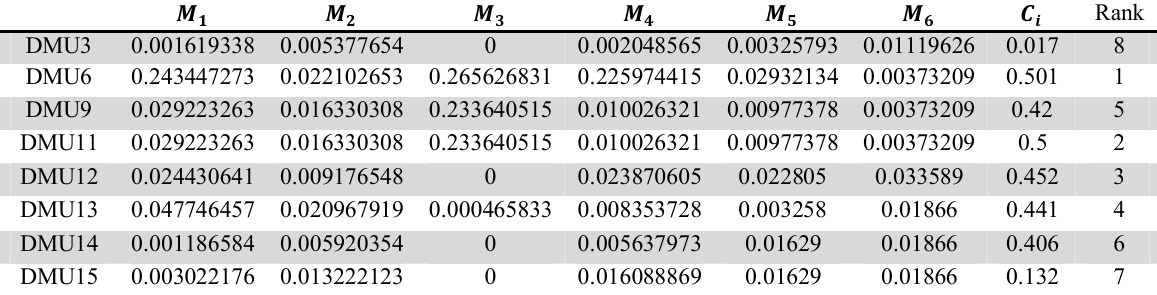
Table 2 demonstrates the results of TOPSIS ranking method using the same inputs/outputs of DEA model by considering equal weights. The summary of the implementation of TOPSIS